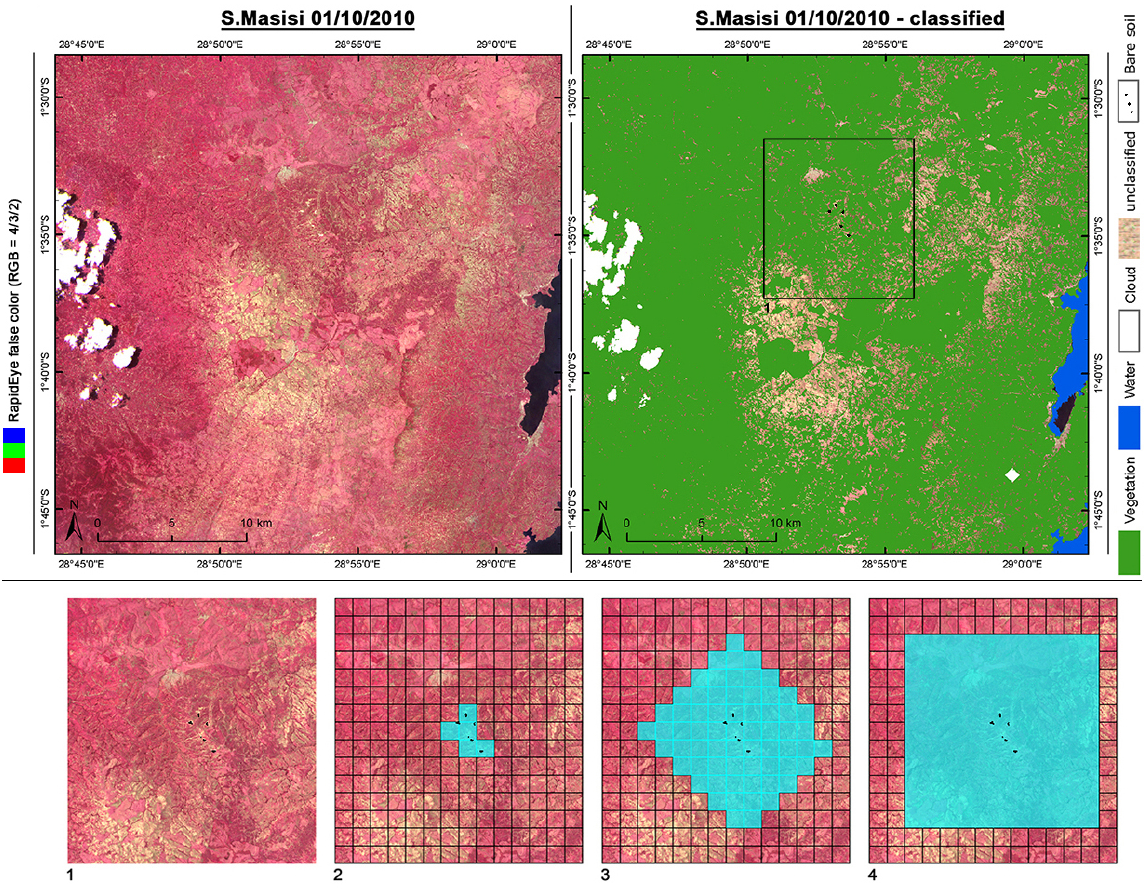
Figure 8. Upper map: Comparison of unclassified ( left ) and classified ( right ) imagery of Southern Masisi. Lower part: Sequence of ROI-definition as explained in Figure 6. The black box in the upper right map is equal to the subset shown in the ROI-definition